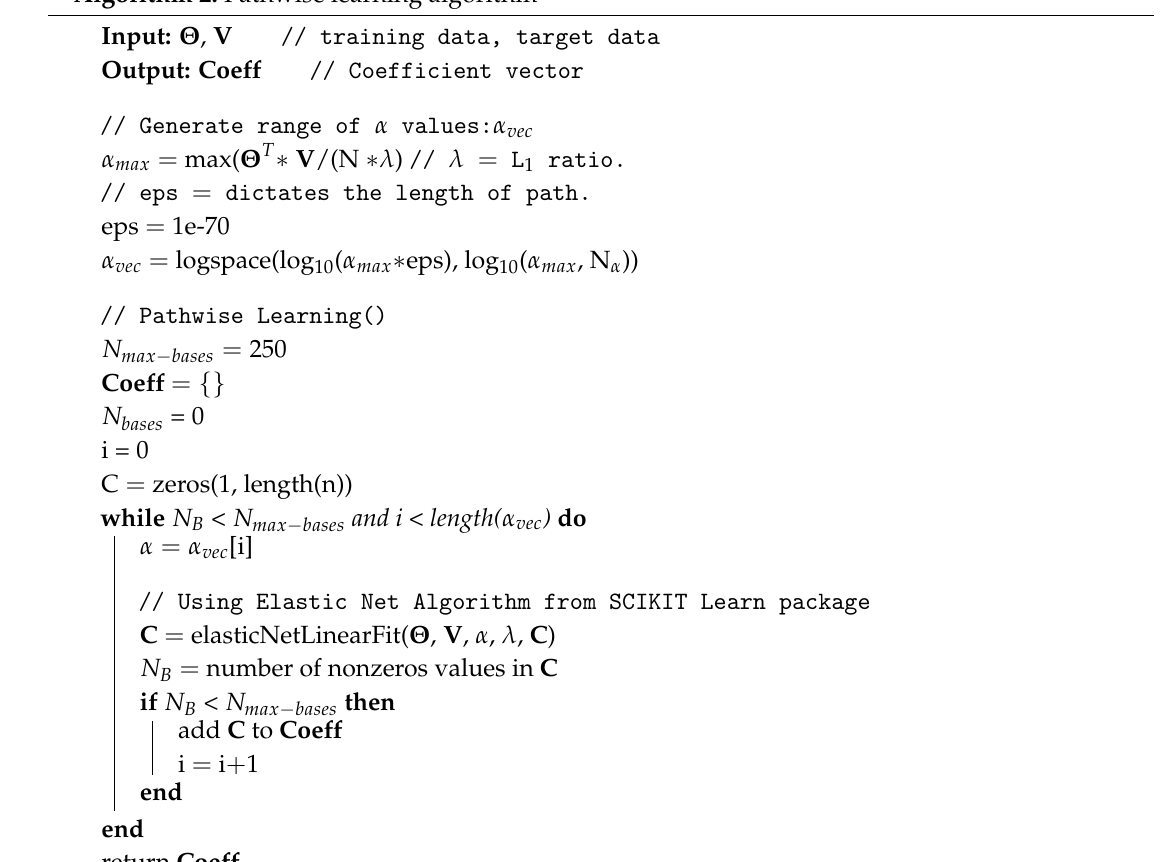
Algorithm 2: Pathwise learning